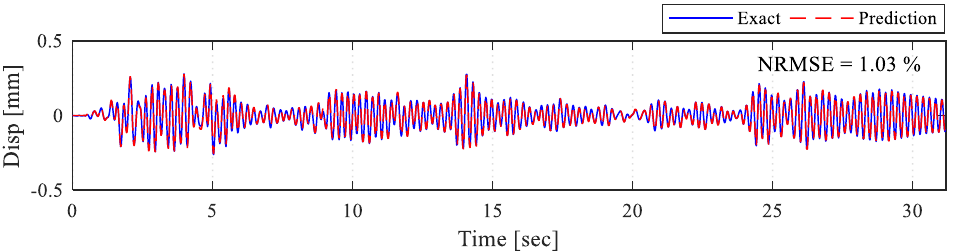
Figure 13. LSTM-predicted brace displacement input from Model 1b RTHS test without specimen but based on actual feedback as compared to the exact analytical solution.